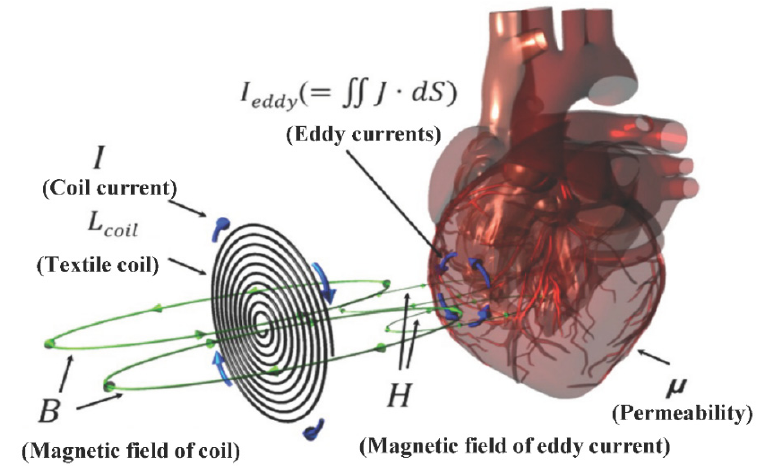
Figure 1. Current and magnetic field induced by the external magnetic field.